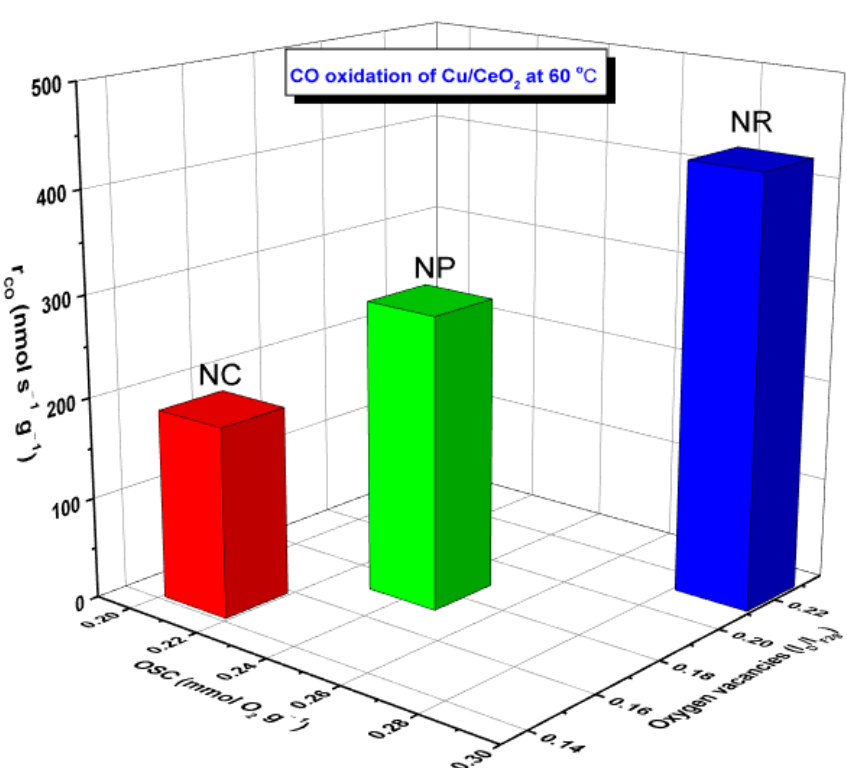
Figure 9. Relationship between the CO oxidation performance (r CO , nmol s − 1 g − 1 ) of Cu/CeO 2 samples and the oxygen storage capacity (OSC, mmol O 2 g − 1 ) as well as the abundance of oxygen vacancies (in terms of I D /I F2g ratio) of ceria nanorods (NR), nanopolyhedra (NP) and nanocubes (NC).